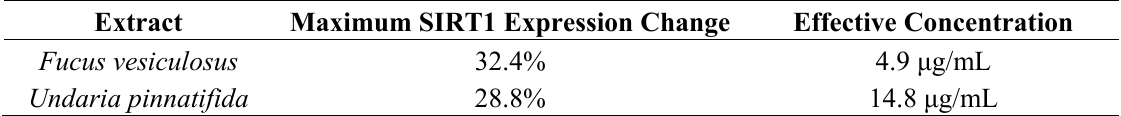
Table 6. Maximum increase in SIRT1 expression (percent change).